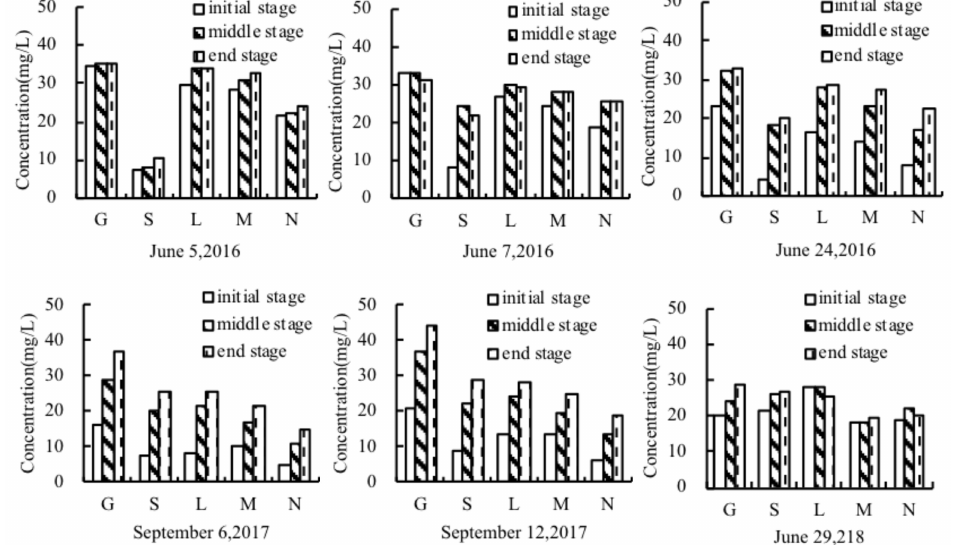
Figure 6. Observed total nitrogen concentration of the subsurface drainage